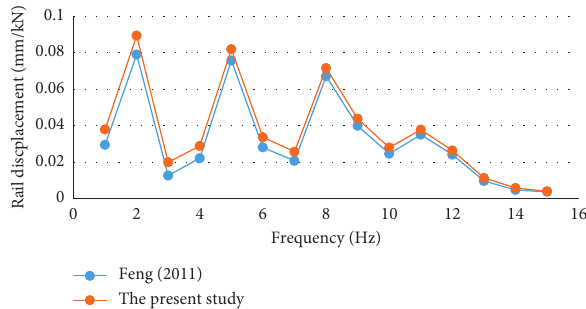
Figure 4: Comparison of the results of rail displacement of FEM model and analytical